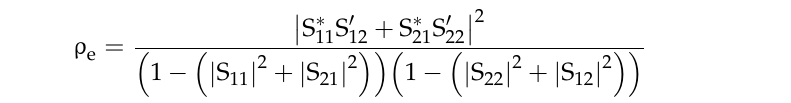
Figure 11. Calculated ECC of the MIMO antenna system.